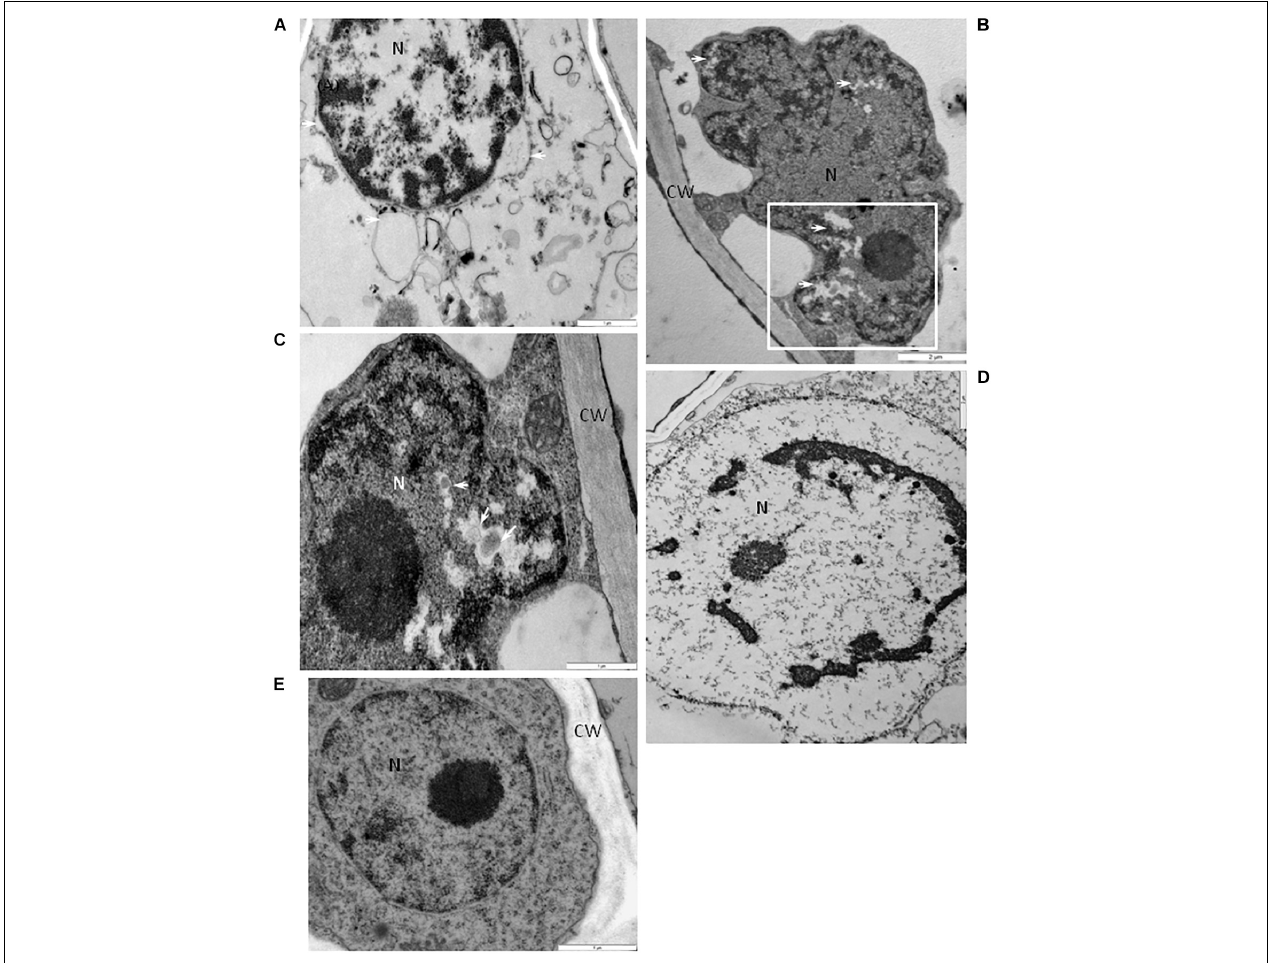
FIGURE 8 | Alterations of the nuclear structure in cells of BPEV-infected tissues. (A) Dilatation of the nuclear envelope (arrows) with vesicles in the perinuclear areas. N-nucleus. Bar 1 µ m. (B) Nucleus (N) with electron-lucent areas (arrows) in a mesophyll cell. CW-cell wall. Framed area enlarged in (C) . Bar 2 µ m. (C) Enlargement from the framed area of figure (B) . Small vesicles (arrows) in electron-lucent area. CW-cell wall, N-nucleus. Bar 1 µ m. (D) Chromatin condensation in nucleus (N). Bar 1 µ m. (E) Nucleus (N) of a BPEV-free phloem parenchyma cell. CW-cell wall. Bar 1 µ m. CC, companion cell; Ch, chloroplast; CLD, callose like deposition; CW, cell wall; ER, endoplasmic reticulum; Ep, epidermis; GA, trans Golgi network; M, mitochondria; Me, mesophyll; MVB, multivesicular bodies; N, nucleus; Ne, necrosis; P, plastoglobules; Ph, phloem; PMB, paramular bodies; SE, sieve element; sg, starch grain; vs, vesicles; V, vacuole; VB, vascular bundle; X, xylem tracheary element; XP, xylem